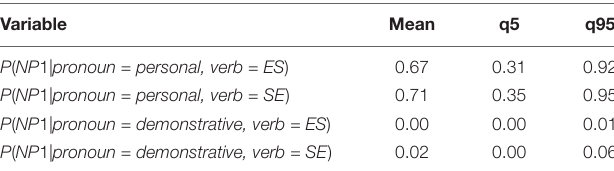
TABLE 17 | Value of P ( NP 1) across verb type and pronoun type for the Bayesian model, Experiment 2.